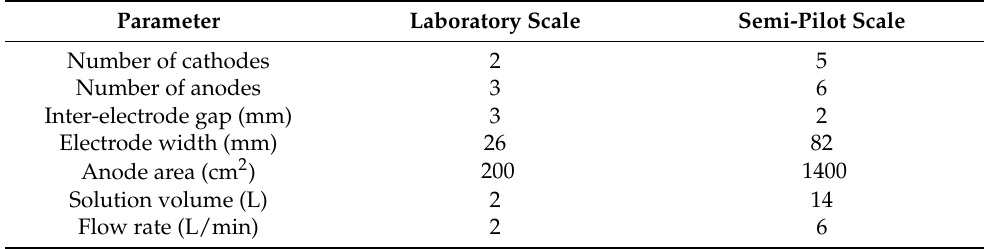
Table A3. Specifications of the electrochemical setup at the laboratory and semi-pilot